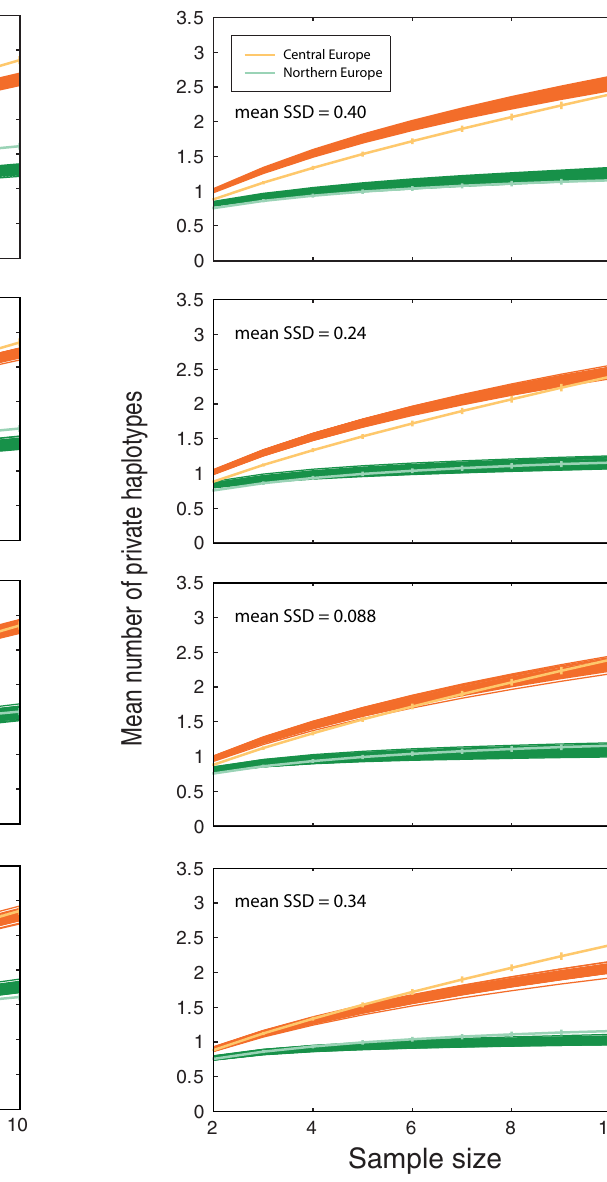
Figure 7. Estimation of the migration rate between the northern and central European populations of A.thaliana . The mean number of distinct haplotypes and the mean number of private haplotypes of two simulated populations as functions of sample size, shown for 100 replicates. The dark orange lines show the simulation results for a population of size N CE =135,000, and the dark green lines show the results for a population of size 135,000 6 1/4, when T =13,500 years. The top panel shows the case when the migration rate, m , equals 0, and then follow the cases with m =3 and m =6 (normalized by N CE ). The results from the observed populations are also plotted for comparison (lighter orange and green lines).